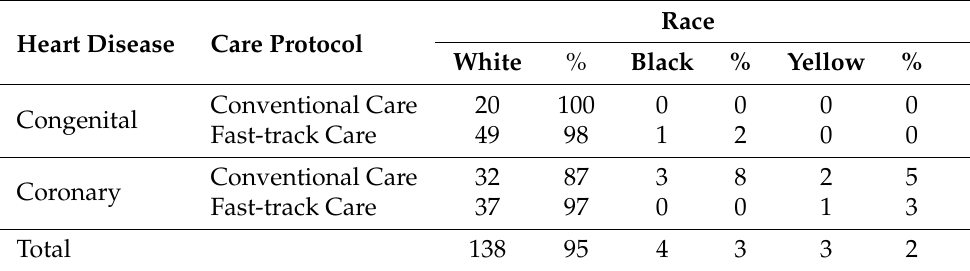
Table 3. Absolute and relative distribution for race of patients with congenital and coronary heart disease followed up in both